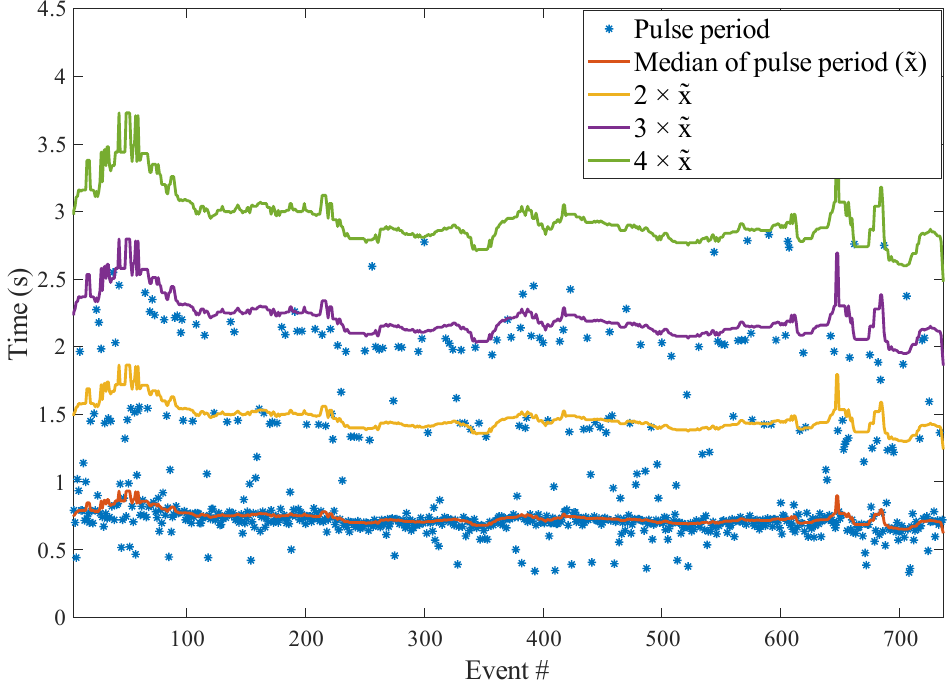
Figure 8. Cardiac event periods and 20-sample moving median value with its integer